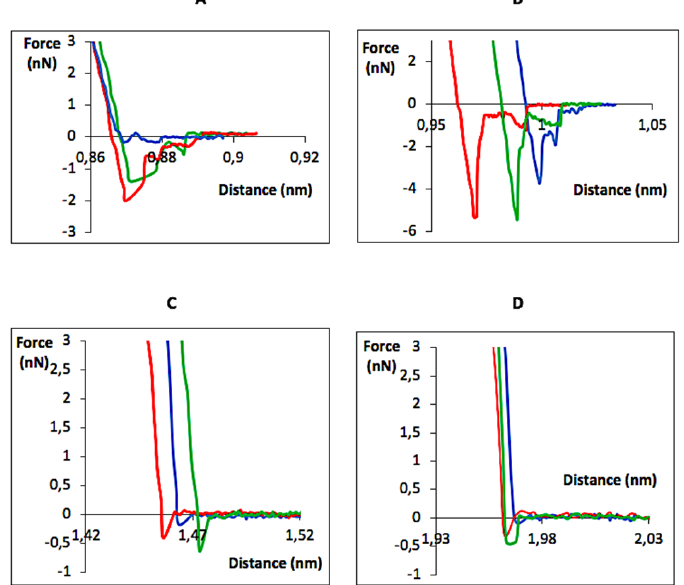
Figure 6. Single ‐ molecule recognition experiments. Representative retraction force ‐ distance curves Figure 6. Single-molecule recognition experiments. Representative retraction force-distance curves between: ( A ) Oriented tip ‐ bound anti ‐ TS mAb 39 and Ex ‐ TcT of T. cruzi ; ( B ) random tip ‐ bound anti ‐ between: ( A ) Oriented tip-bound anti-TS mAb 39 and Ex-TcT of T. cruzi ; ( B ) random tip-bound TS mAb 39 and Ex ‐ TcT of T. cruzi ; ( C ) random tip ‐ bound anti ‐ TS mAb 39 and “TS ‐ free” Ex ‐ TcT of anti-TS mAb 39 and Ex-TcT of T. cruzi ; ( C ) random tip-bound anti-TS mAb 39 and “TS-free” Ex-TcT T. cruzi ; and ( D ) random tip ‐ bound anti ‐ TS mAb 39 and Ex ‐ TcT ≈ mAb 39 immune complexes. Red, of T. cruzi ; and ( D ) random tip-bound anti-TS mAb 39 and Ex-TcT ≈ mAb 39 immune complexes. Red, blue and green line are representing the overlay of different F ‐ D patterns for the same interaction). blue and green line are representing the overlay of different F-D patterns for the same